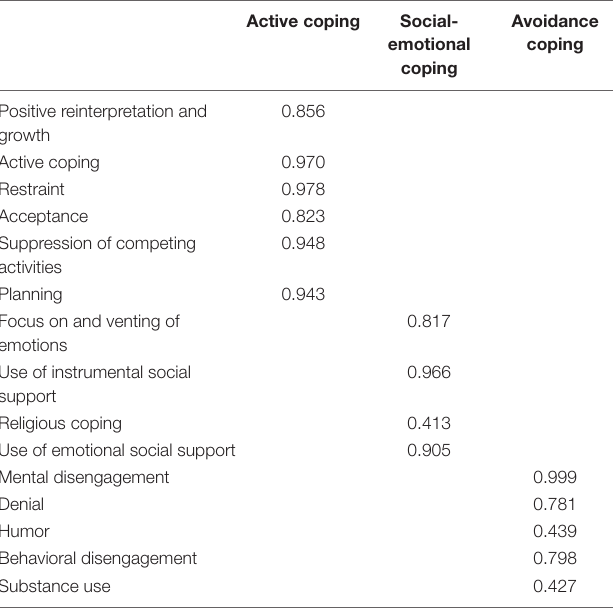
TABLE 2 | Factor loadings of the second-order CFA simultaneously testing both the first level (15 first-order factors) and second level (3 second-order factors) structure of the